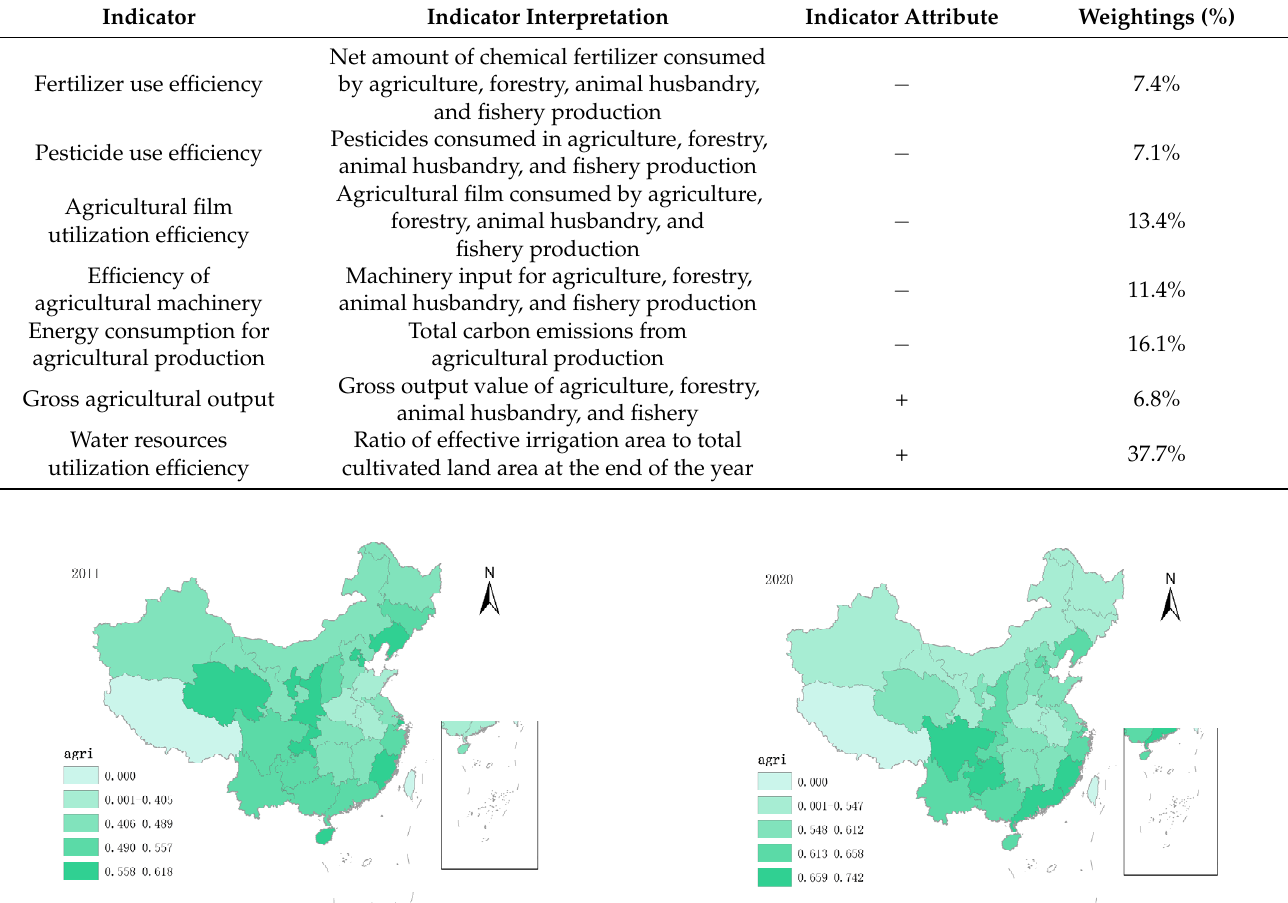
Figure 4. Green development level of agriculture by provinces in 2011 and 2020. Table 2. Agricultural green development level index system.